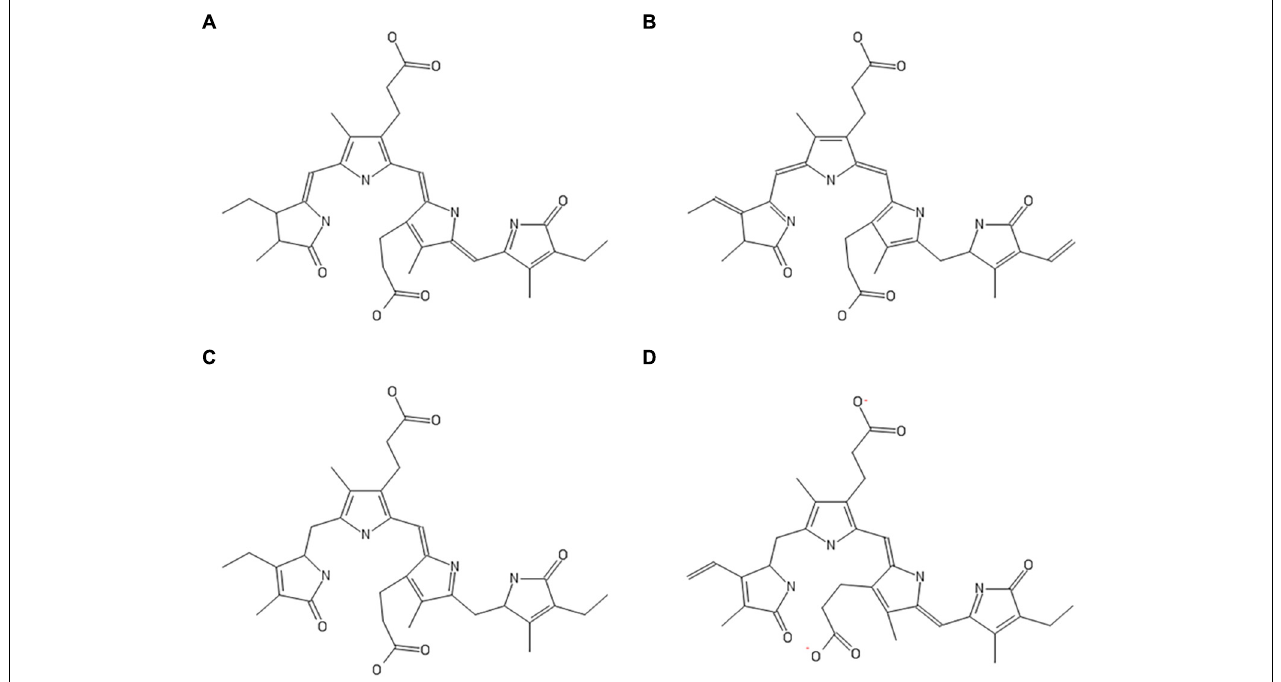
FIGURE 4 | Molecular structures of phycobilins; (A) PCB; (B) PEB; (C) PUB; (D) PVB.